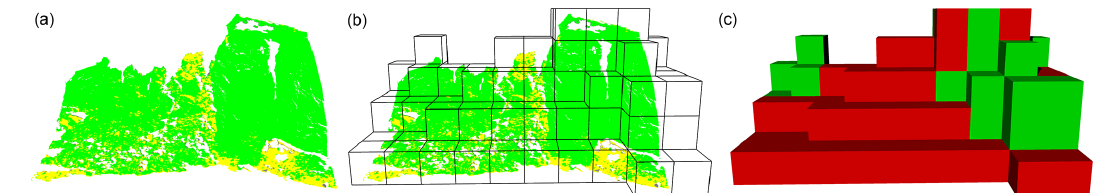
Figure 2. (a) Binary change map of a test case. (b) Octree structure that contains the scene. (c) Stable (green cubes) and unstable (red cubes) octree cells after congruence analysis.